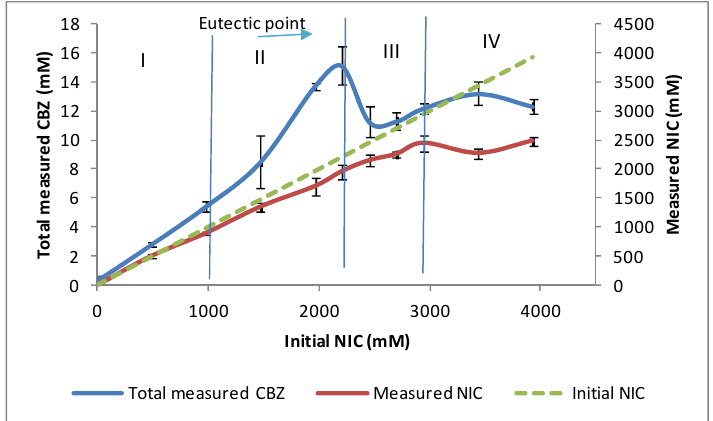
Figure 3. Apparent CBZ solubility profile as a function of NIC concentration after 72